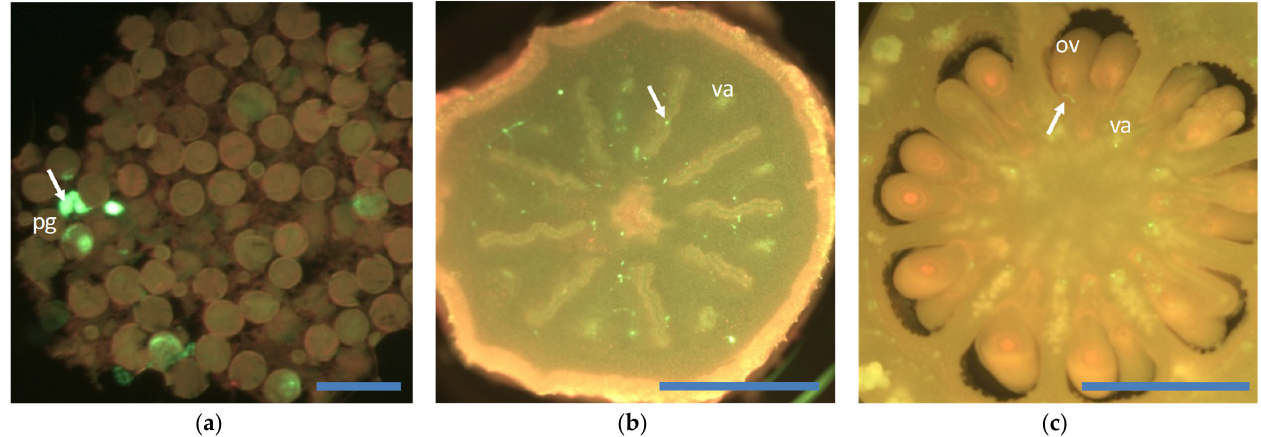
Figure 3. Histological observations in the ‘Monreal’ clementine x ‘Oroblanco’ triploid hybrid 10 days after pollination. ( a ) Large quantity of pollen grains observed on the stigma surface displaying poor pollen germination; ( b ) very low quantity pollen tubes growing throughout the bottom half of the stigma; ( c ) one pollen tube reached ovules. Pollen tubes marked by an arrow; pg: pollen grain; va: vascular axis; ov: ovule. Scale bars are denoted by blue lines: ( a ) 100 µm; ( b ) and ( c ) 1 mm.